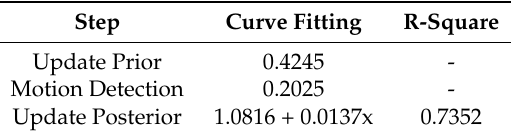
Table 9. FPGA version, latency per block